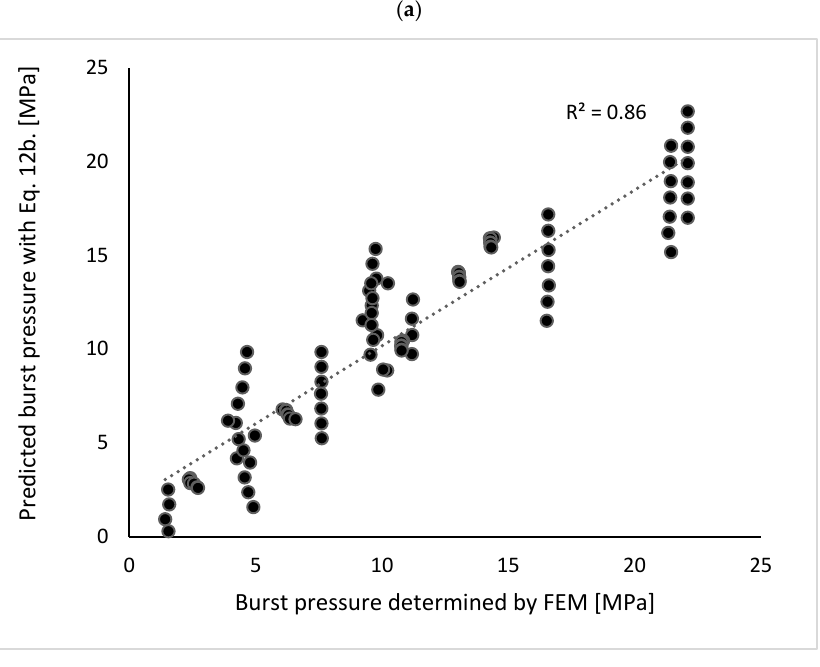
Figure 8. Variation of the burst pressure retention ratio with d/t for 323.6 mm diameter and 8.51 mm thick pipe for various corrosion defect lengths mm.